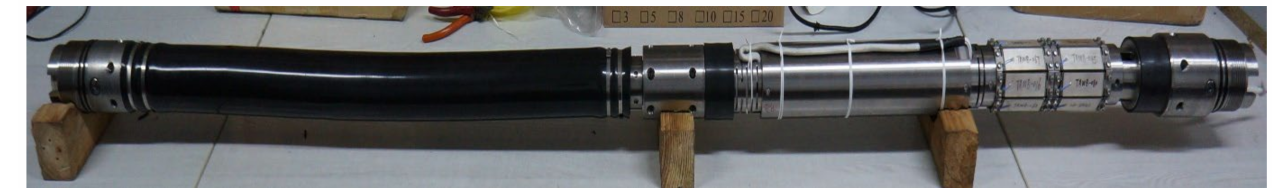
Figure 3. Structure diagram of an acoustic sonde composed of an azimuthal-transmitting arc array.